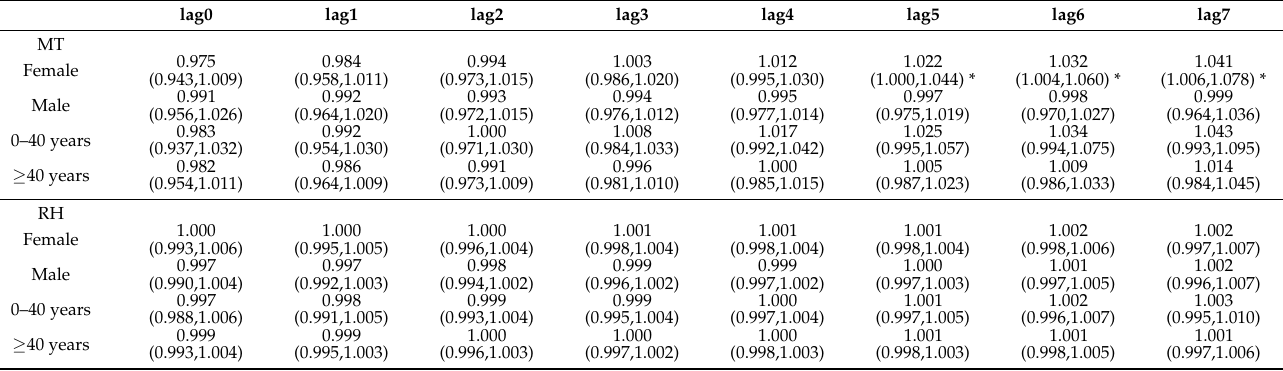
Table 3. Relative risk of the 25th percentile of ambient temperature and relative humidity on HZ outpatients in